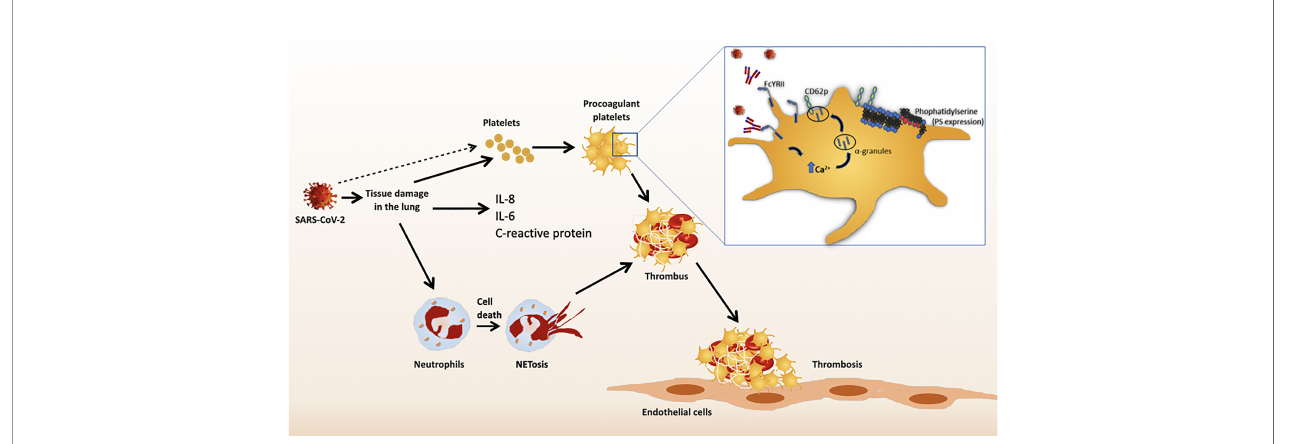
FIGURE 1 | Schematic representation of immune mediated platelet activation in